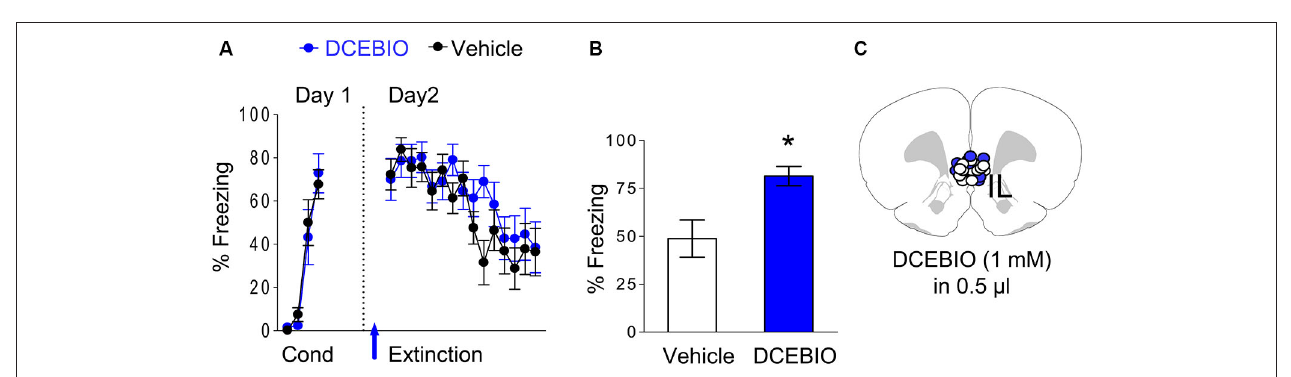
DCEBIO-infused rats showed enhanced fear expression on day 3, consistent with impaired recall of extinction memory. (C) White dots (VEH) and blue dots (DCEBIO) represent the cannula placements for